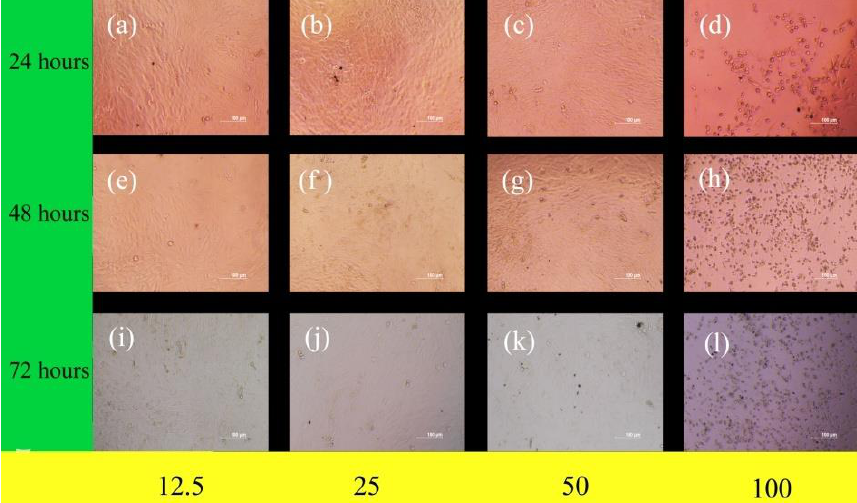
Figure 10. Microscopic images of MG-63 human cells seeded to different proportions of extract medium.